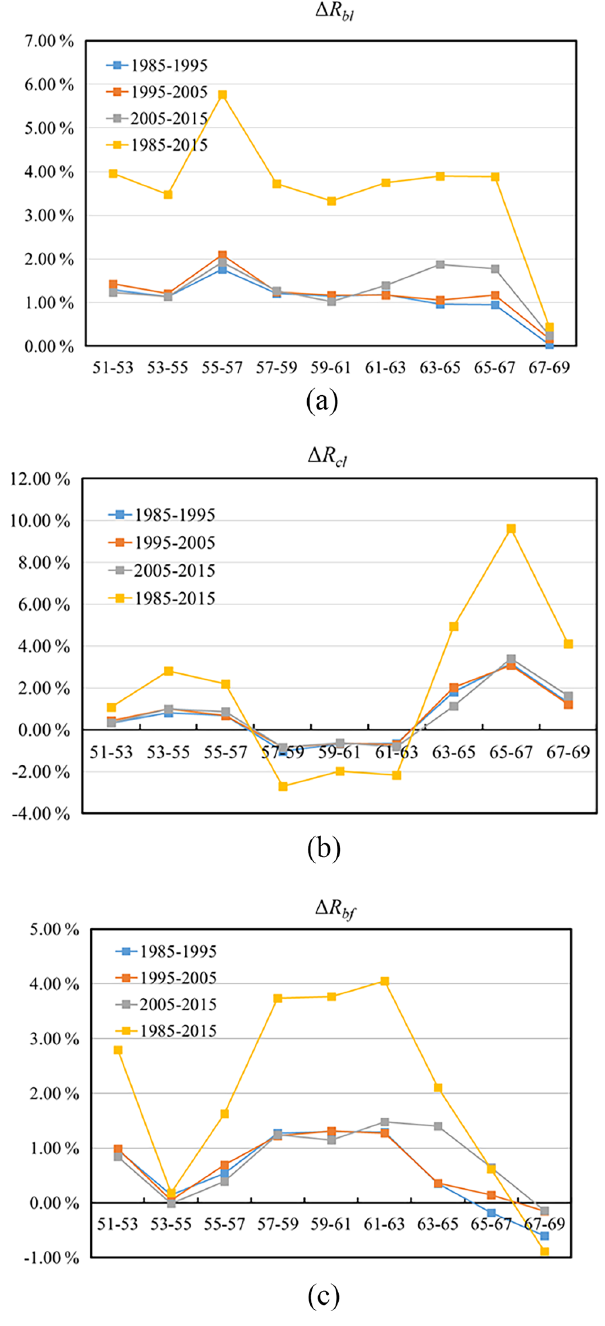
Figure 9. Changes in different forest types in different latitude zones: (a) (cid:49)R bl , (b) (cid:49)R cl and (c) (cid:49)R bf .